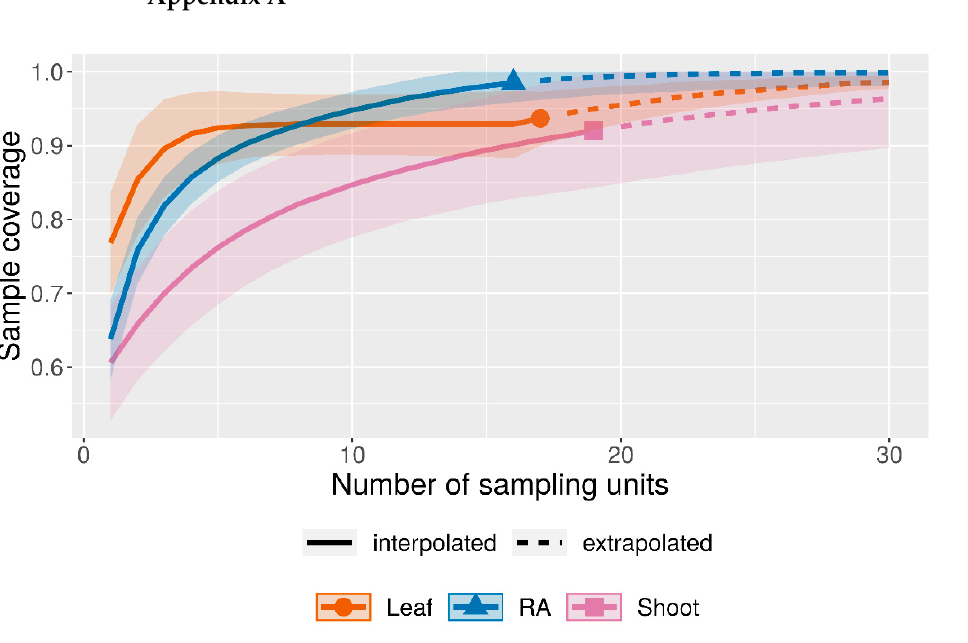
Figure A1. Sample completeness curve based on incidence data according to Chao et al. (2016) [64]. Number of bootstraps used: 500; level of confidence: 0.95. RA = P. crispa mats, Leaf = P. oceanica leaves, Shoot = P. oceanica shoots with sample coverages (C.hat) of 0.98, 0.93 and 0.92, respectively.